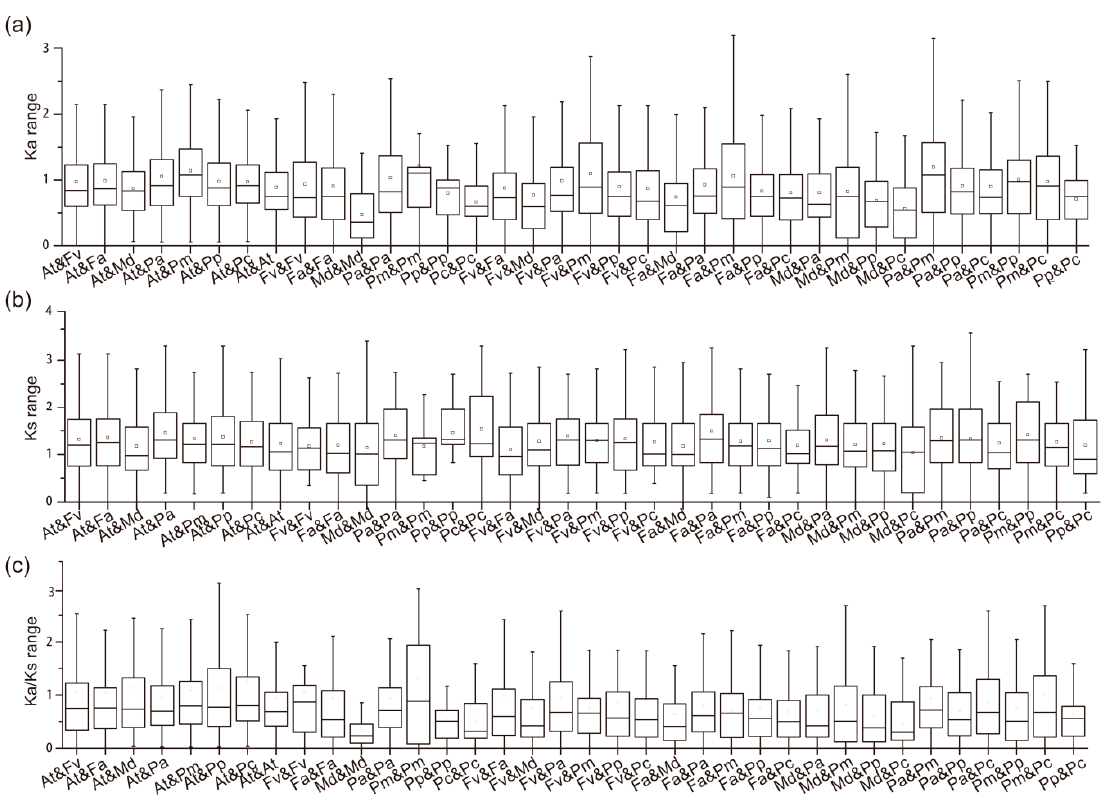
Figure 4. The ka, ks, and ka/ks value distributions. ( a ) ka values; ( b ) ks values; ( c ) ka/ks values.